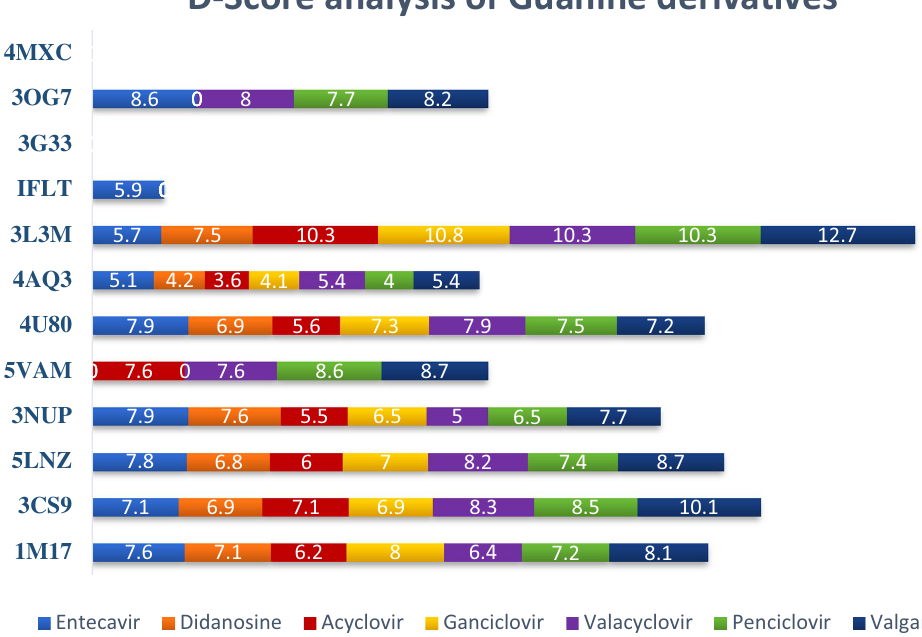
Figure 2. D-score analysis of seven guanine derivatives with twelve receptors (The color codes for the seven ligands are given under the figure).